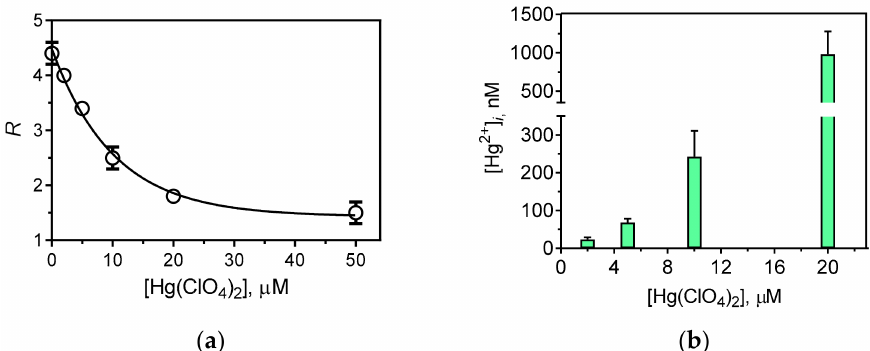
Figure 5. Detection of intracellular Hg 2+ ions using a ratiometric approach with compound 1 . ( a ) Dependence of the ratio R of fluorescence intensities I (500–600 nm)/ I (600–730 nm) on the concentration of Hg(ClO 4 ) 2 added to cells. Data were averaged over 20 cells in each measurement and presented as a mean ± SD. ( b ) Estimation of intracellular concentration of Hg 2+ ions ([Hg 2+ ] i ) at different concentrations of Hg(ClO 4 ) 2 added to cells. Cells were pre-incubated with different concentrations of Hg(ClO 4 ) 2 for 15 min, washed twice with Hanks’ solution, incubated with 1 (10 µ M) for 20 min, and measured with